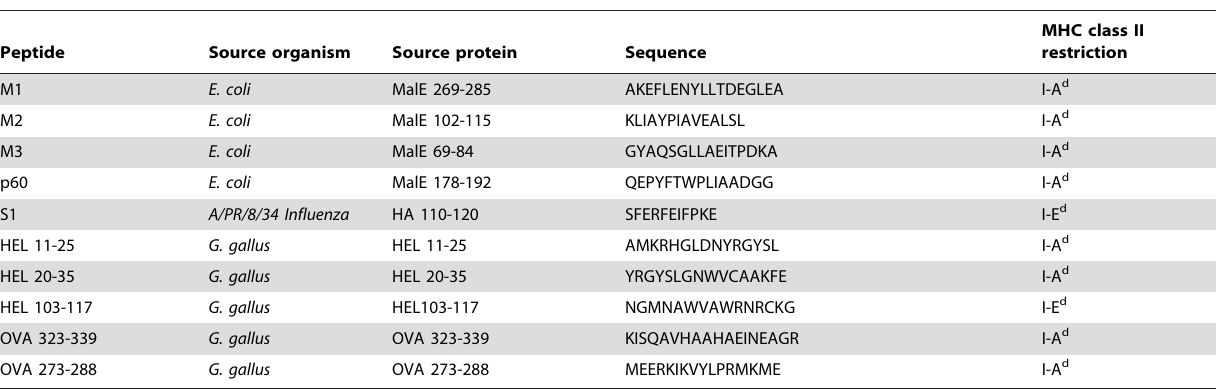
Shown are the antigenic peptides from maltose binding protein (MalE), hemagglutinin (HA), hen egg lysozyme (HEL), ovalbumin (OVA) that were used with APC to restimulate T cells ex vivo in cytokine-specific ELISPOT assays in Figures 4 to 9.